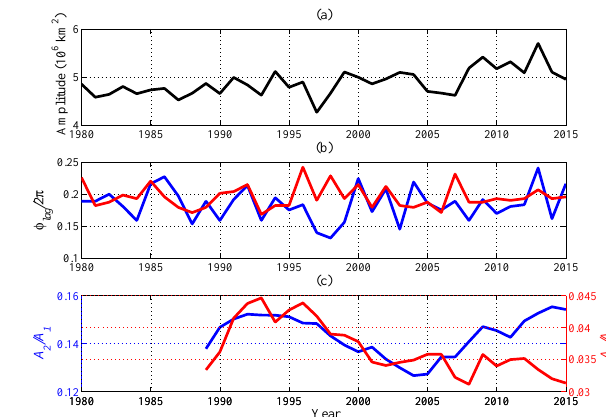
Figure 10. In the upper panel amplitude of sea ice area within each cycle is plotted against year. In the middle panel phase lag is plotted between the sea ice area minimum (red line) and maximum (blue line) and the solar insolation minimum and maximum respectively against the year. In the lower panel, the 2nd (blue) and 3rd (red) harmonic amplitudes A n /A 1 are plotted against year end using a sliding window of 10years. The amplitude is increasing however the phase lag is not. Harmonic amplitudes also show no convincing trend.